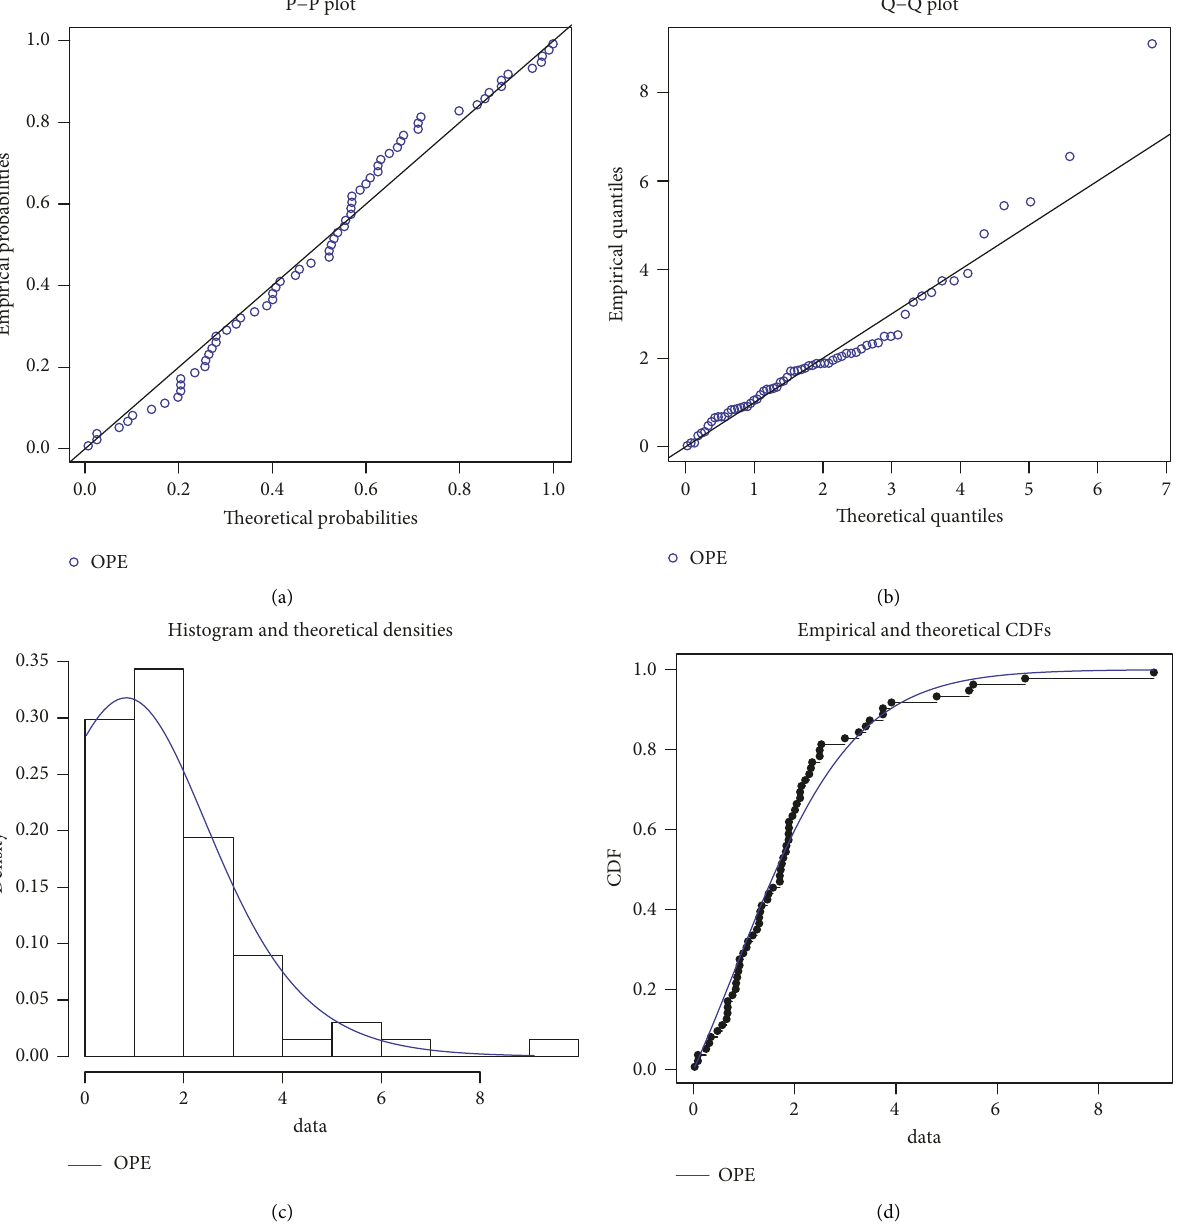
Figure 2: (a) P-P plot, (b) Q-Q plot, (c) histogram fitted by the estimated pdf, and (d) empirical cdf fitted by estimated